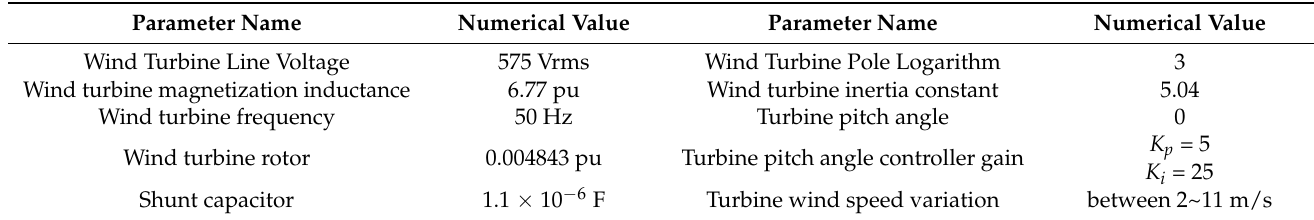
Table 5. Individual parameters of the wind power